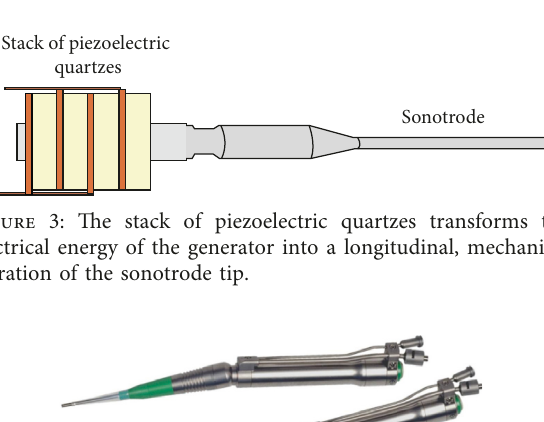
Figure 2: Ultrasound generator: hand-piece recognition and au- tomatic adaptation; three frequencies: 25, 35, and 55kHz; auto- matic self-test of all of the important functions predefined power steps or direct adjustment; and optical and acoustical indicator.